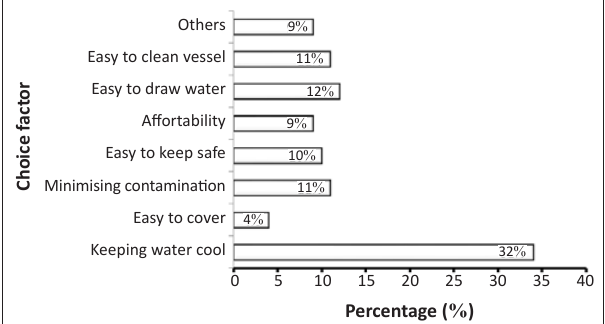
FIGURE 4 : Factor determining the choice of household water drinking vessels.